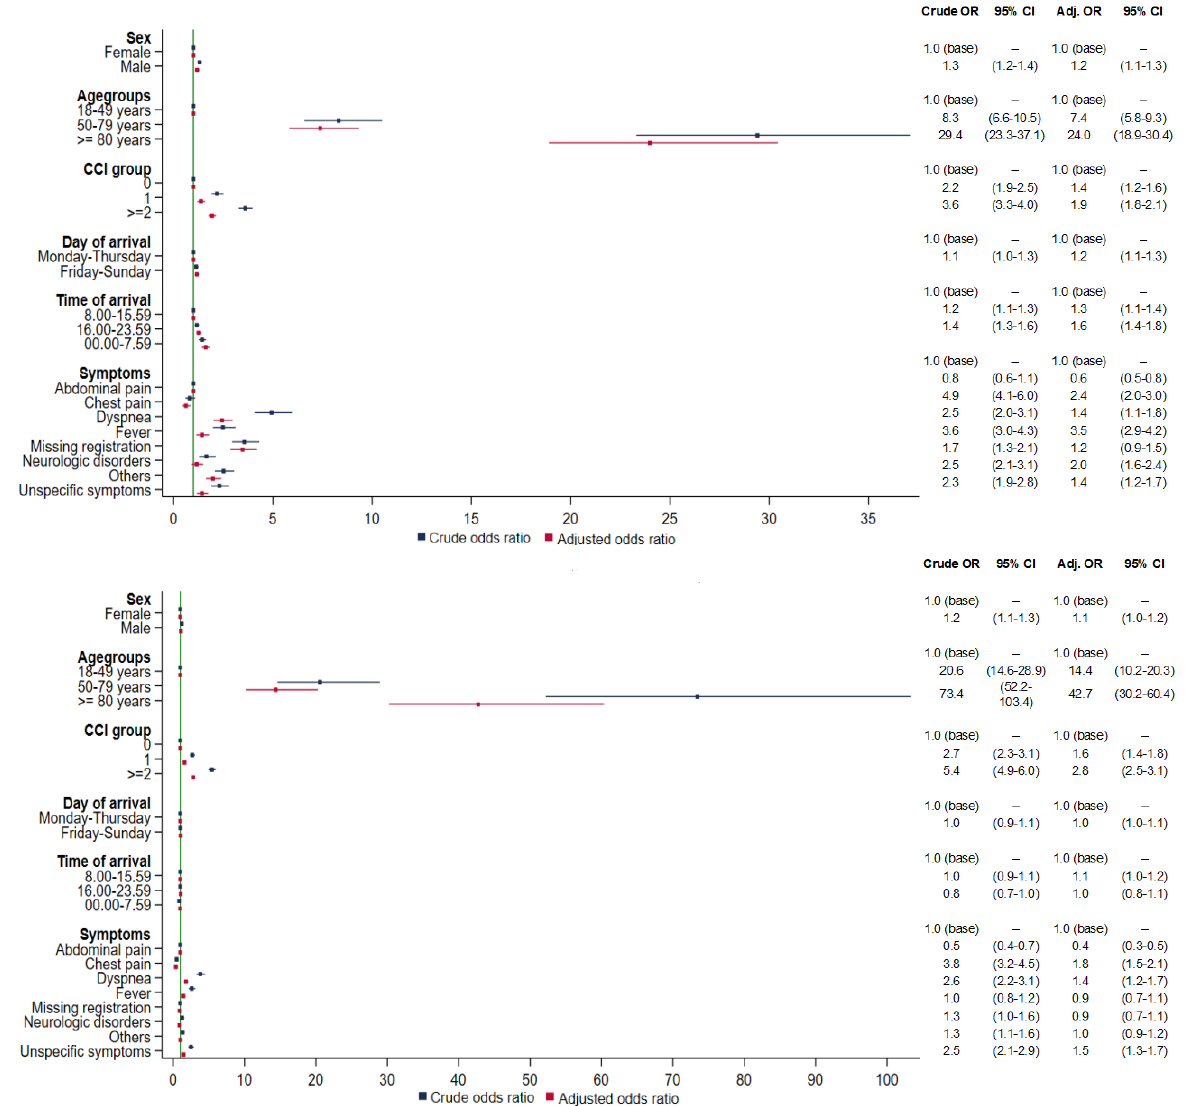
Figure 2. Odds ratios and adjusted odds ratios for the association between risk factors and mortality at 0-7 (A) and 8-30 days (B) among adult, non-trauma, emergency department patients arriving at a hospital in the Region of Southern Denmark between 2016- 2018. CCI, Charlson Comorbidity